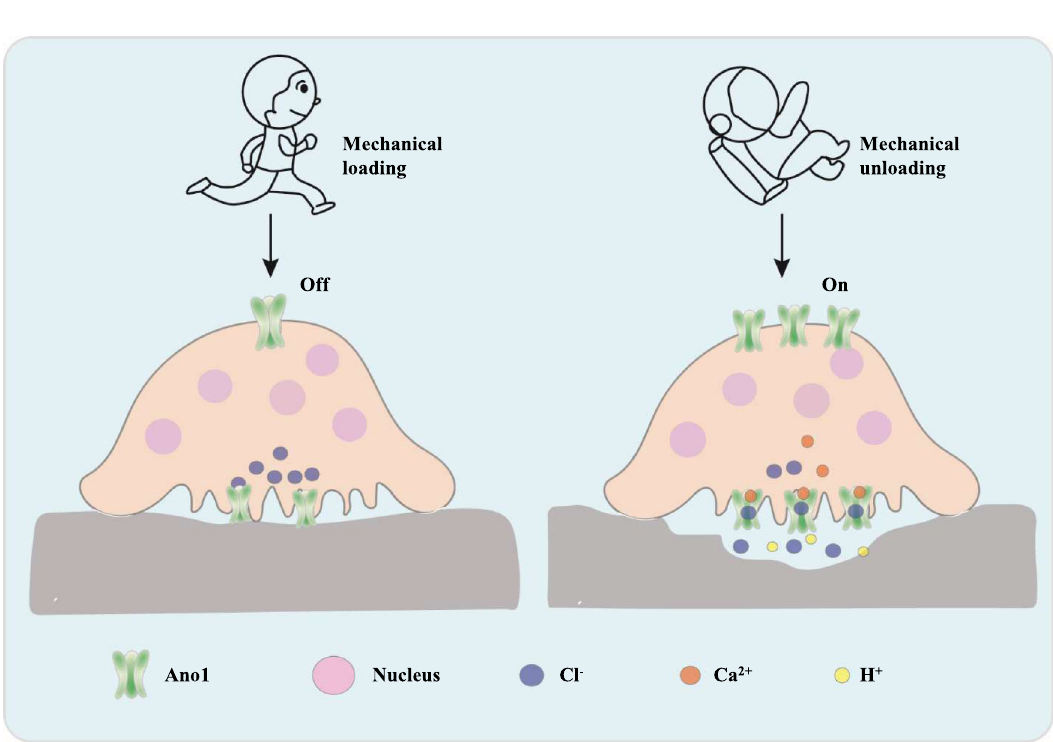
Fig. 8 Schematic model depicting the role of Ano1 in the regulation of mechanical stimulation on osteoclas. Ano1 functions a mechanical sensor in osteoclast through its calcium regulated channel